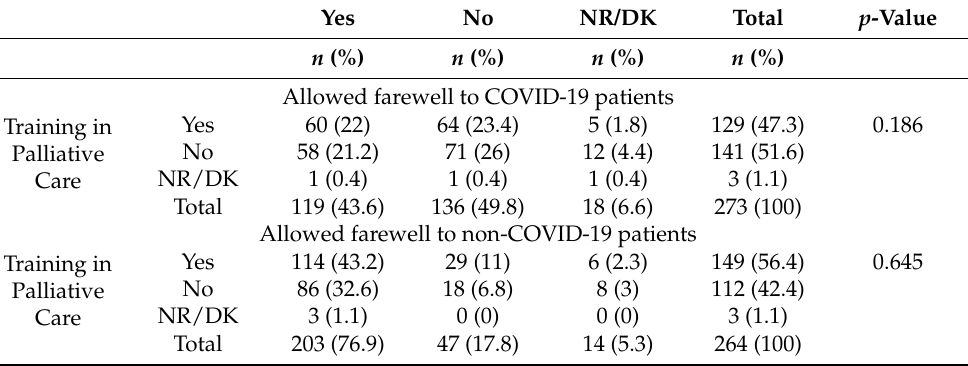
Table 2. Farewell to COVID-19 and non-COVID-19 patients and palliative care training for the nurses who cared for them.